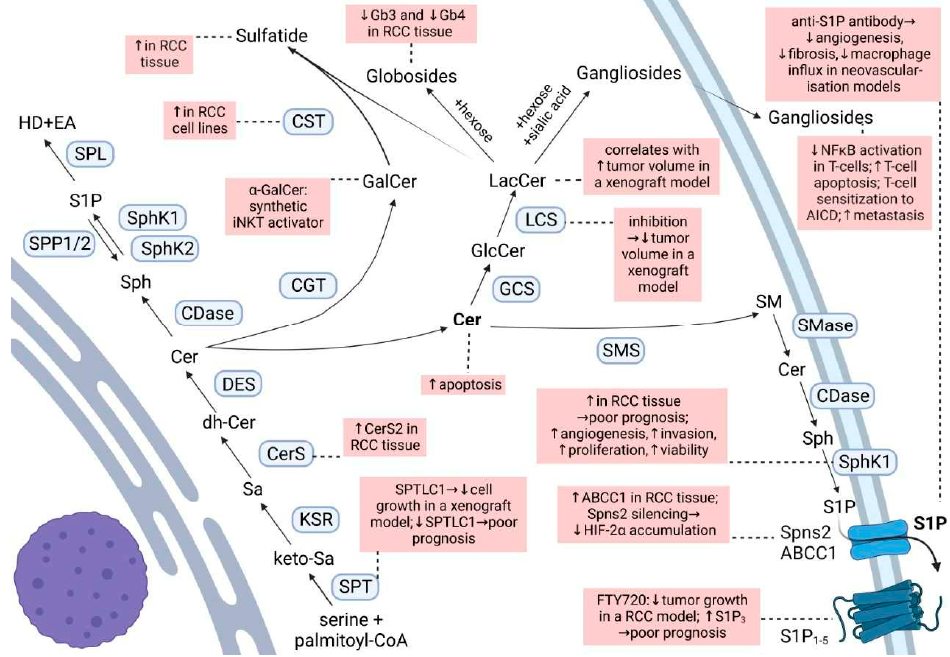
Figure 1. Sphingolipid biosynthesis and degradation routes. Changes reported for RCC are highlighted in pink boxes. For abbreviations, see text.